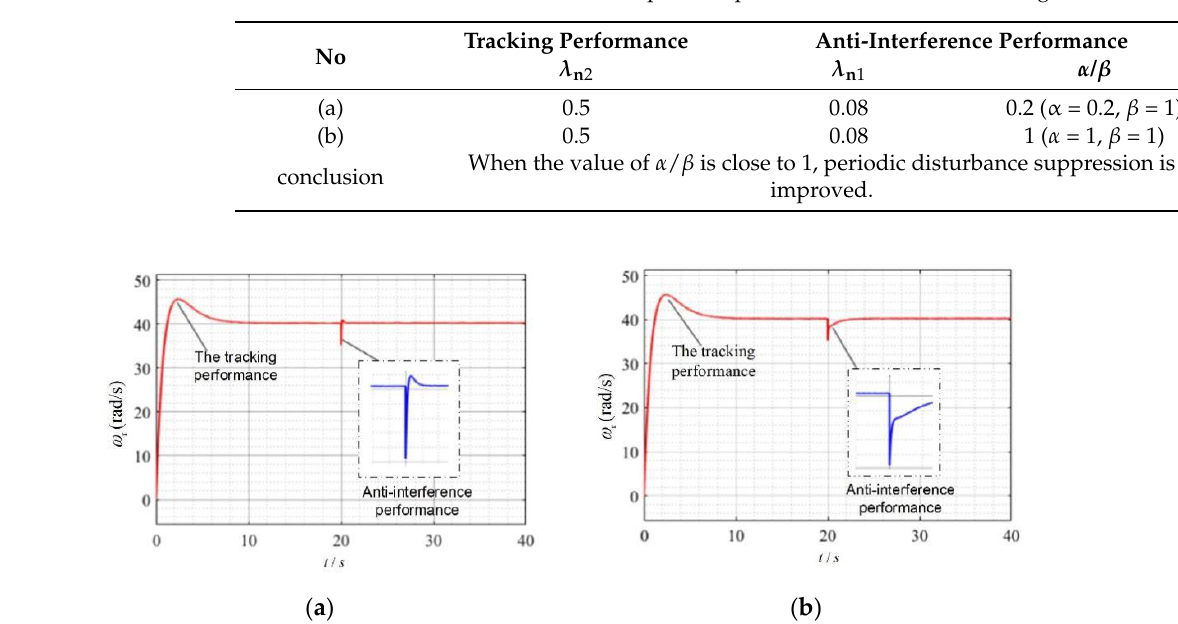
Table 4. Two-step disturbance schemes and corresponding conclusions. Table 5. Two schemes and conclusions of periodic perturbation with sine wave signal.